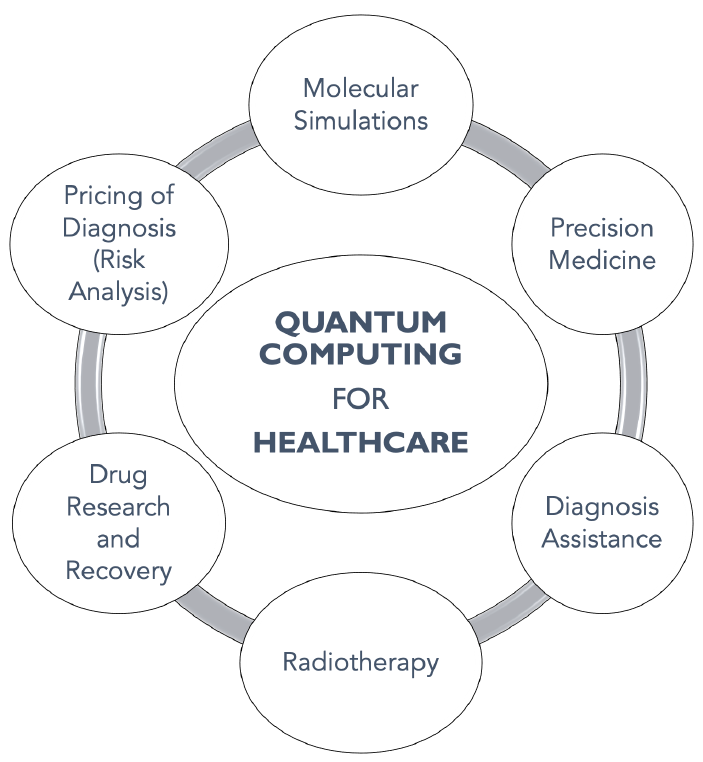
Figure 4. Taxonomy of different potential applications of quantum computing for healthcare